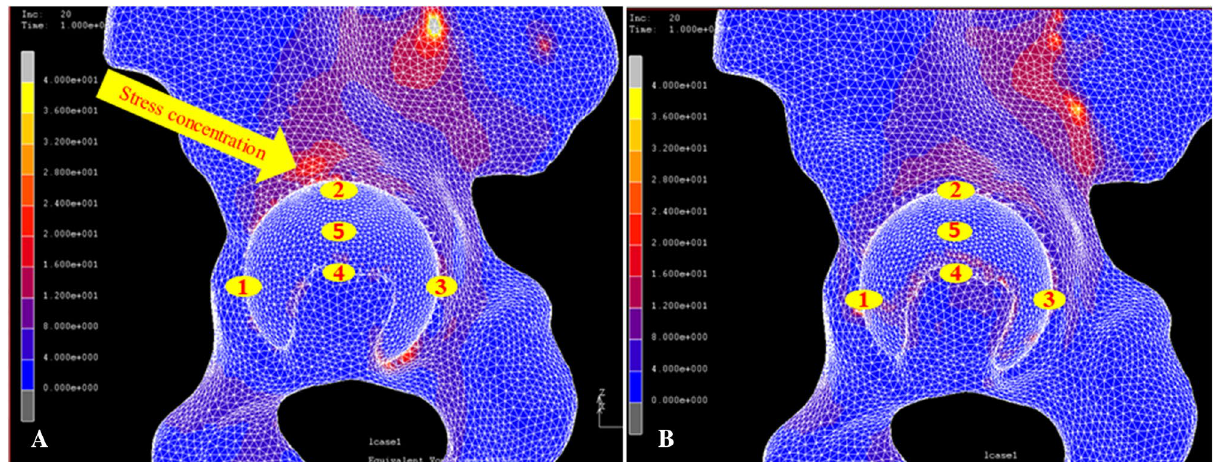
Figure 5. Illustration of the stress distribution and micromotion with the conventional reaming technique ( A ) and with the anatomical technique ( B ). The maxim micromotion (46 μm) was in the bottom of the acetabulum (Point 4) with the conventional reaming technique, and the stress concentration was in the superior portion of the acetabulum (yellow arrow) ( A ). The maximum micromotion (37 μm) was in the bottom of the acetabulum (Point 4) with the anatomical technique. There was no stress concentration in the superior portion of the acetabulum, and the stress was similar in the bottom and other areas ( B